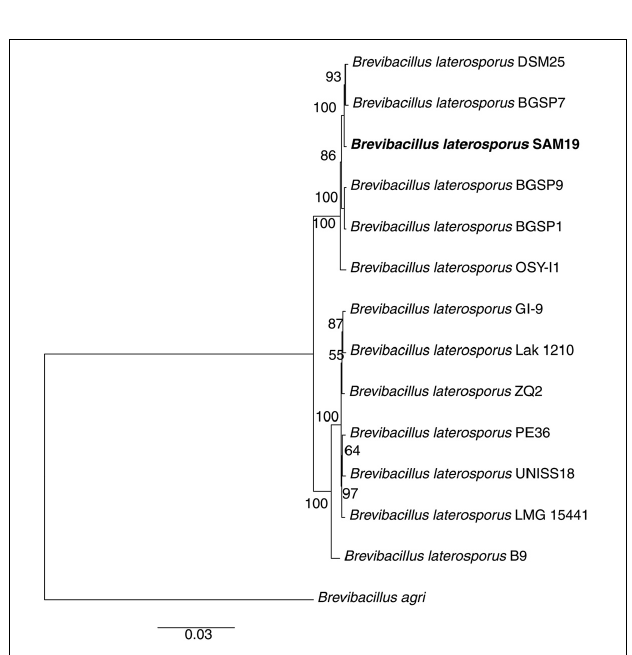
FIGURE 3 | Transmission electron microscopy (TEM) images of Brevibacillus laterosporus strains SAM19 and LMG 15441 at different growth stages: Vegetative cell during exponential phase; Sporangium including forming spore at 24 h after inoculum; Free spore. CW, cell wall; S, spore; SC, spore coat; F-CSPB, forming canoe-shaped parasporal body; CSPB, canoe-shaped parasporal body.